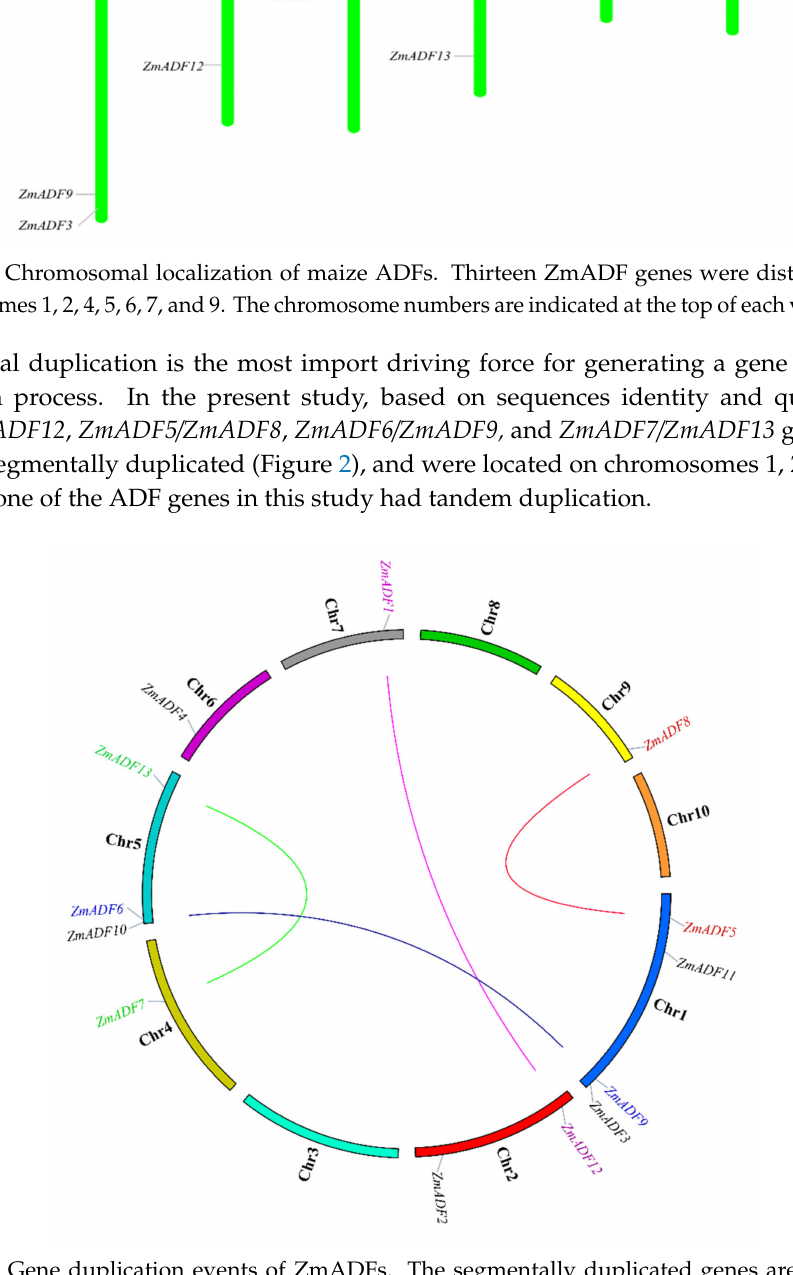
Figure 2. Gene duplication events of ZmADFs. The segmentally duplicated genes are linked by di ff erent color